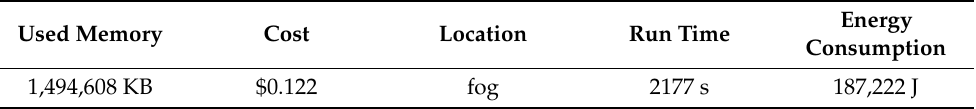
Table 10. Task ID 224334 specifications.